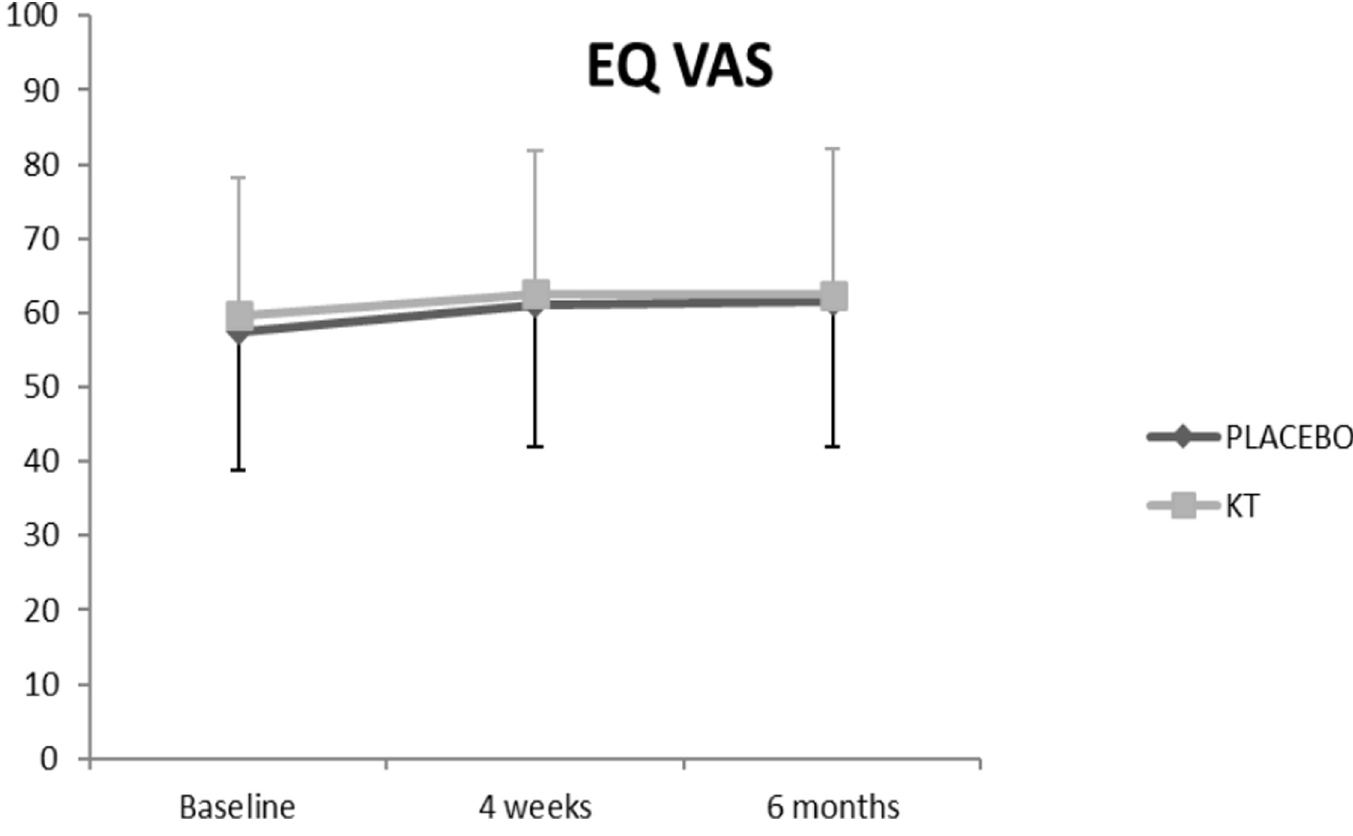
Fig 7. Effects of the intervention on EQ VAS.